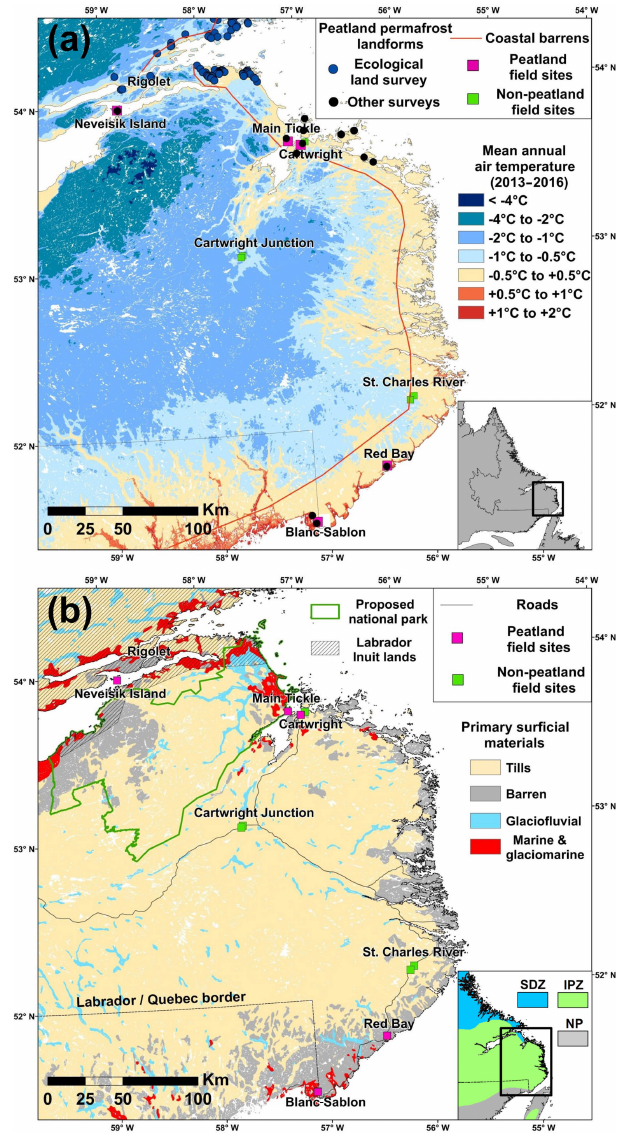
Figure 1. Location of peatland and non-peatland study sites in southeastern Labrador in relation to (a) gridded (100m resolution) mean annual air temperatures (2013–2016) (Way et al., 2017) and peatland landforms mapped in various studies, and (b) surficial ma- terials (Fulton, 1995). The inset map in (a) shows the study location in eastern Canada, and the boundary of the coastal barrens ecozone (Roberts et al., 2006) is shown as an orange line. Labrador Inuit lands and the proposed Mealy Mountains National Park are out- lined in (b) . The inset in (b) shows the boundaries of permafrost zones (after Heginbottom et al., 1995) where SDZ is the sporadic discontinuous zone, IPZ the isolated patches zone, and NP no per-